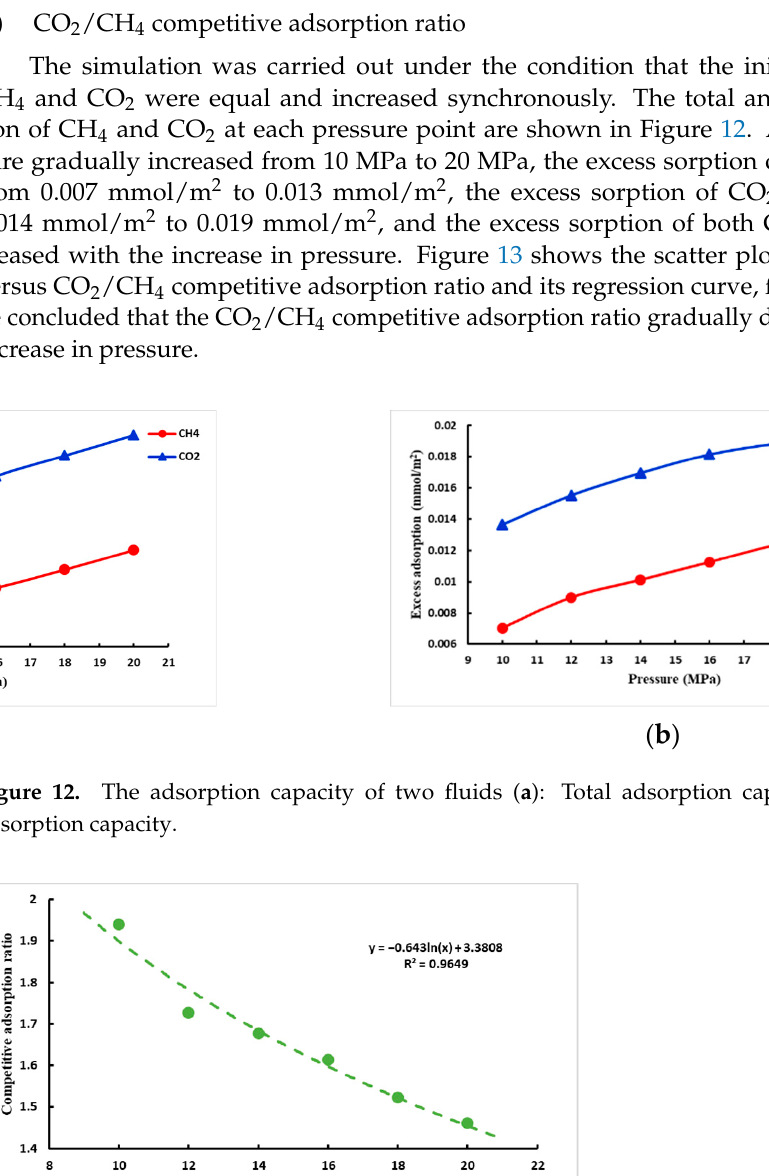
Figure 11. Relation curve between CO 2 storage capacity and injection pressure.